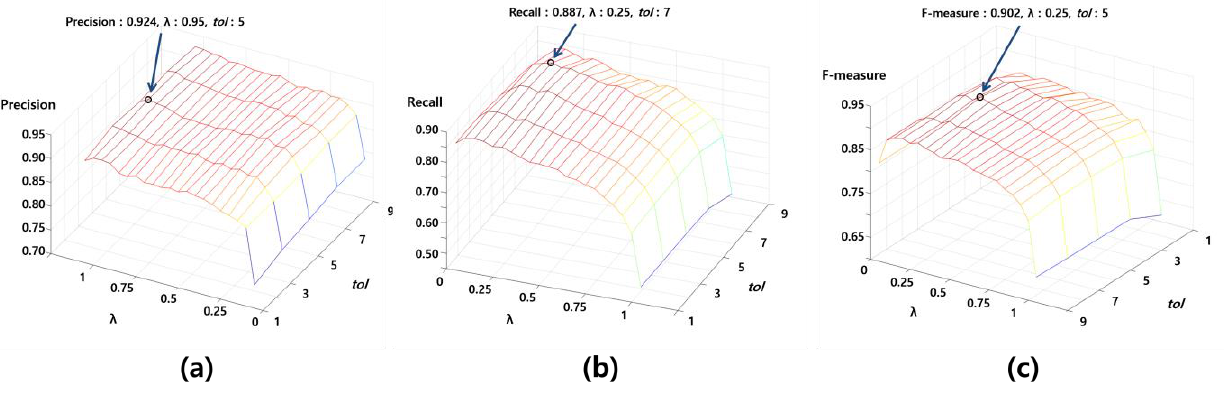
Figure 11. Accuracy evaluations of the proposed method according to the two parameters 𝜆 and 𝑡𝑜𝑙 : ( a ) precision, ( b ) recall and ( c ) the